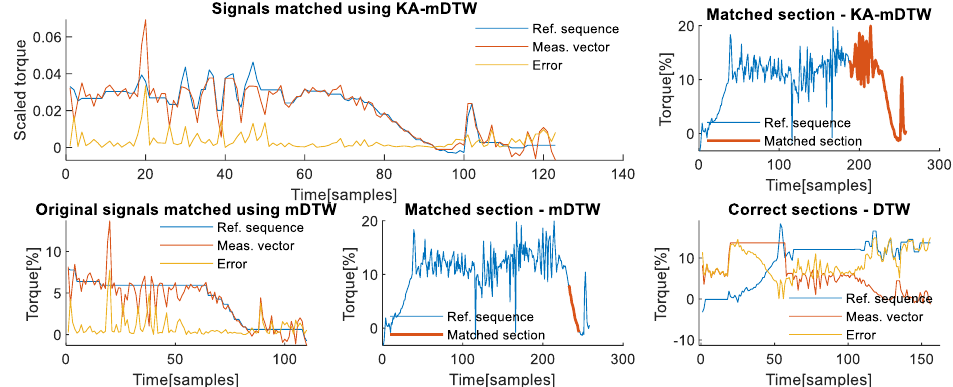
Figure 5. Matching of chosen signals from the 2nd axis. ( Upper left ) Optimally matched section of the reference sequence and the entire measurement vector and the sample-wise matching error. ( Upper right ) Reference sequence profile with the highlighted section, which was correctly interpreted and optimally matched with the measurement vector. ( Lower left ) Section of reference sequence incorrectly recognized and matched with measurement vector using mDTW without scaling the signals. ( Lower middle ) Reference sequence profile with the highlighted section, which was incorrectly recognized and matched with the measurement vector using mDTW. ( Lower right ) The section of the reference sequence identified by KA-mDTW is matched with the measurement vector using DTW algorithm to determine a realistic matching error.